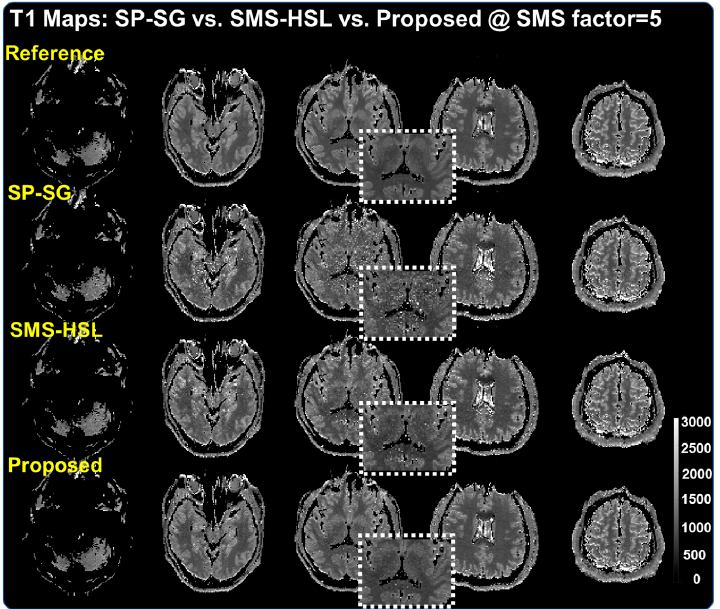
Figure 4. Corresponding T1 maps calculated from SP-SG, SMS-HSL, and our proposed method at an SMS factor of 5. The results from SP-SG exhibit uneven T1 values in the same tissue due to the presence of severe noise while SMS-HSL results display improved conditioning with generalized null space kernels although some noise is still visible. The proposed method provides the best T1 values, with high precision, due to the improved low rank of the Hankel structured matrix. For quantitative evaluation, T1 relaxation curves are shown in Figure 5. The values within manually chosen 3 × 3 pixel white and gray matter regions of interest (ROI) were averaged. The T1 values for white and gray matter follow the pattern of the aforemen- tioned results. The proposed method follows the true signal intensity curve much more accurately than the other methods, which display some signal bias due to signal nulling during inversion recovery. The disparity between the proposed method and the other methods is more pronounced for white matter. Figure 5. T1 signal intensity curves of white and gray matter regions. The curves are generated from the reference and the reconstructed images by averaging the voxels in each region of interest. The signal curves from the proposed method strictly follow the decay curves of the reference, SP-SG and SMS-HSL.